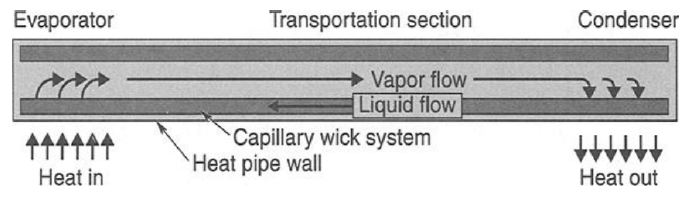
Figure 9. Heat Pipe—schematic.